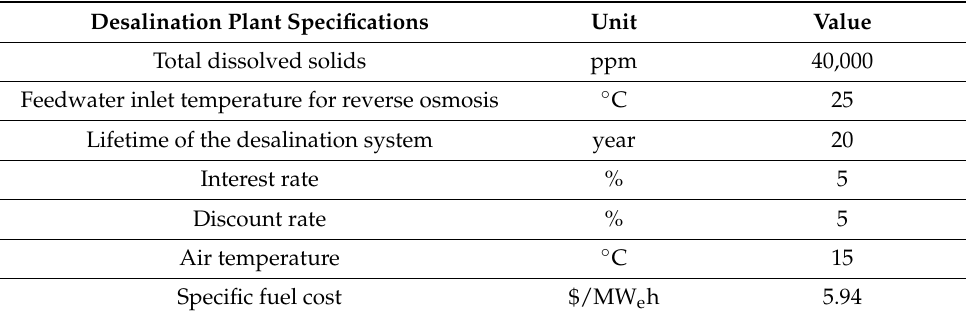
Table 4. Basic parameters for economic